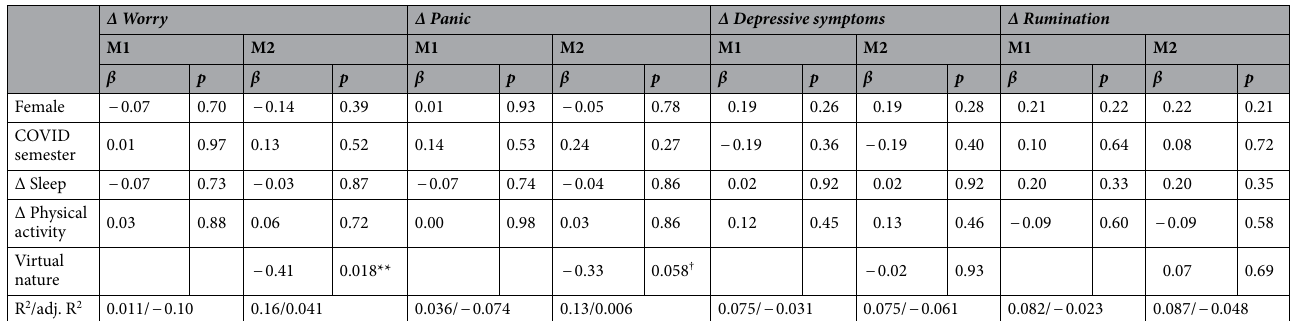
Table 2. Regressing mental health changes on daily virtual nature exposure (N = 40). M1 = Model 1, which provides a base model without the virtual nature intervention; M2 = Model 2, which adds the virtual nature intervention to the base model; ** p < .01, † p <